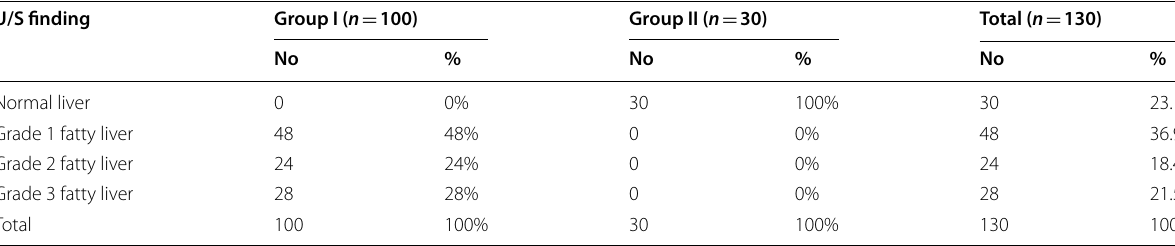
Table 4 Ultrasonographic (U/S) findings among the studied groups